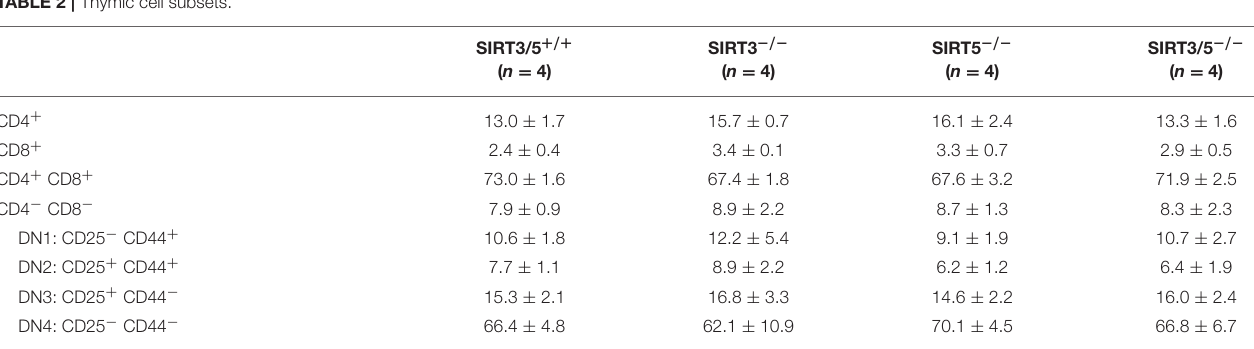
TABLE 2 | Thymic cell